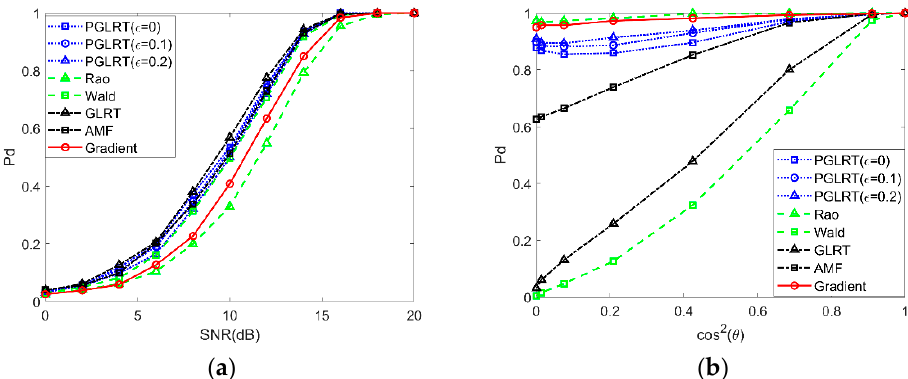
2 θ = 1; d versus SNR for cos